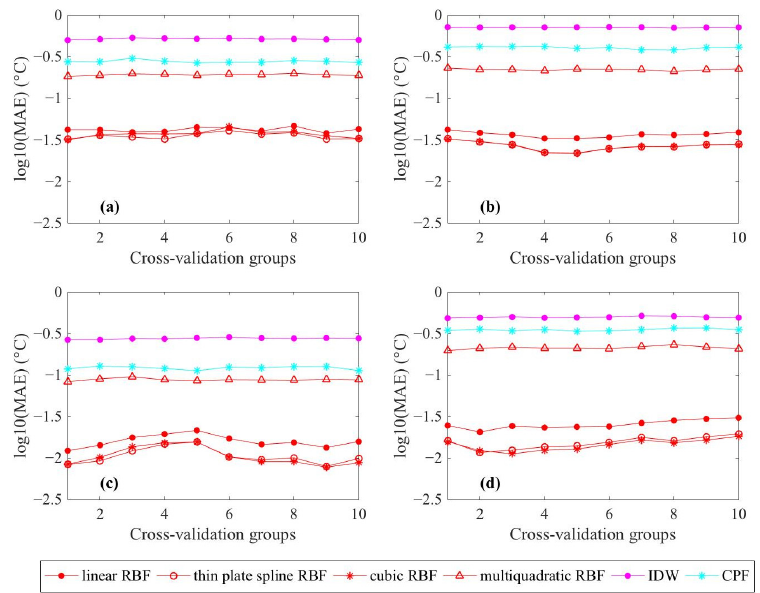
Figure 3. The log 10 (MAE) of each method in the 10-fold cross-validation experiments for temperature interpolation. ( a ) Summer 2010; ( b ) Summer 2011; ( c ) Autumn 2010; and ( d ) Autumn 2011.